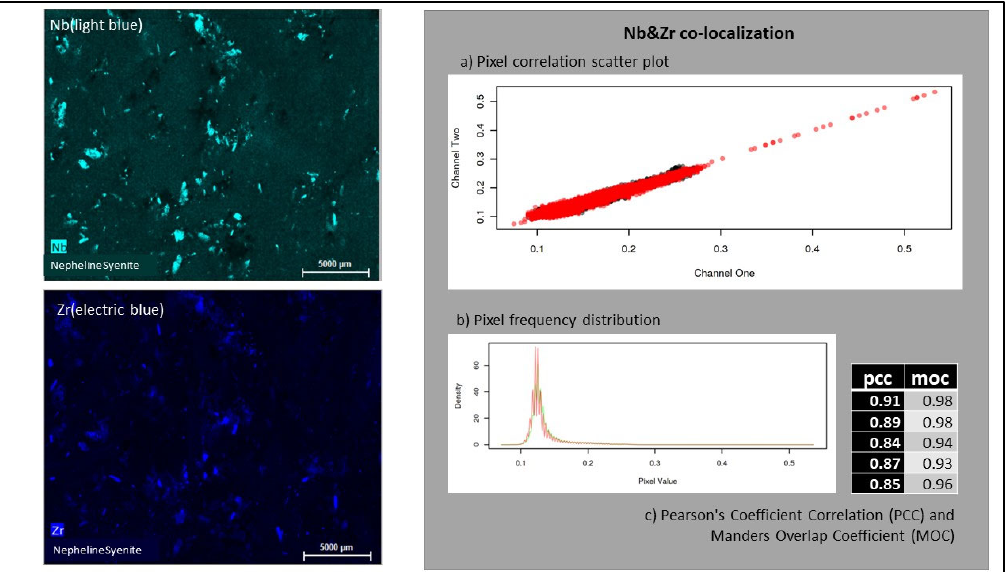
Figure 13. Nb and Zr μ‐ EDXRF maps and their co ‐ localization statistics. ( a ) Pixel correlation scatter plot, ( b ) pixel frequency distribution, and ( c ) Pearson’s coefficient correlation (PCC) and Manders overlap coefficient (MOC).